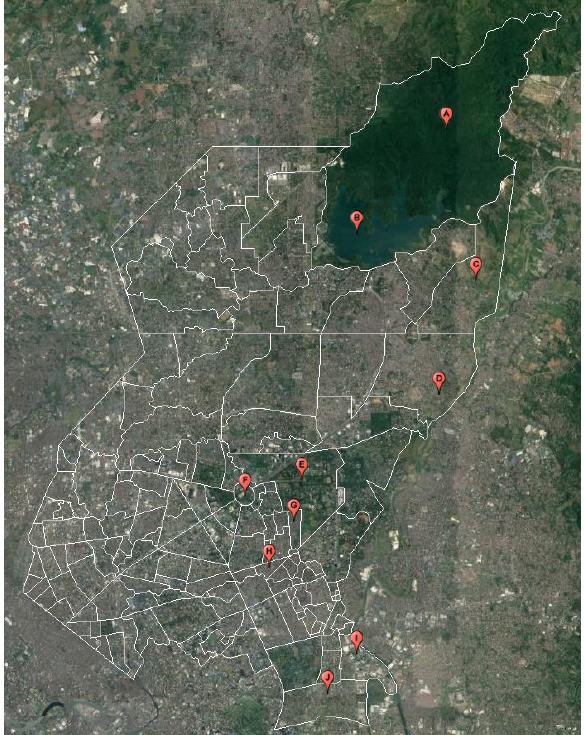
Figure 2. Google Earth Image of Quezon City: (A) La Mesa Watershed, (B) La Mesa Dam, (C) Bagong Silangan, (D) Barangay Batasan Hills (E) University of the Philippines Diliman, (F) Quezon City Memorial Circle, (G) Barangay Krus